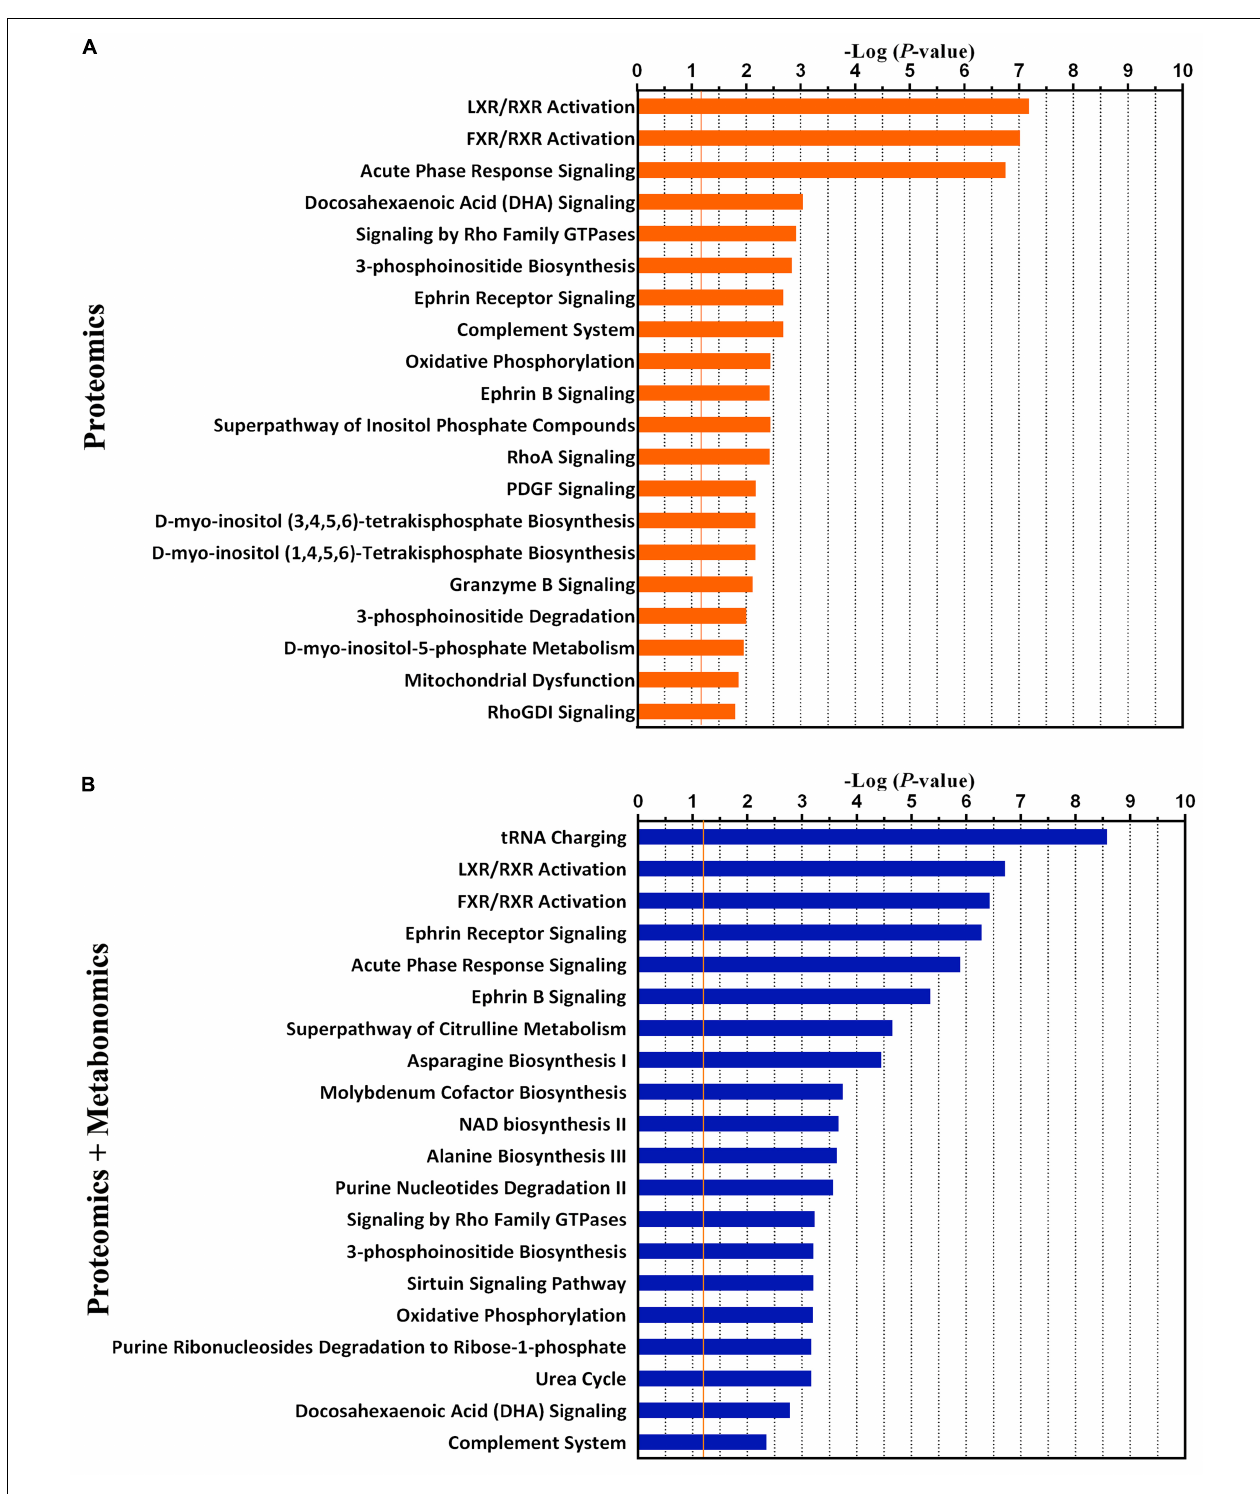
FIGURE 4 | The top 20 canonical pathways of proteomics data only (A) and the combination of proteomics and metabolomics (B) by the Ingenuity Pathway Analysis (IPA). The P -value was obtained by Fisher’s exact test. The Y -axis represents the canonical pathway terms, and the X -axis represents the -Log 10 ( P -value).